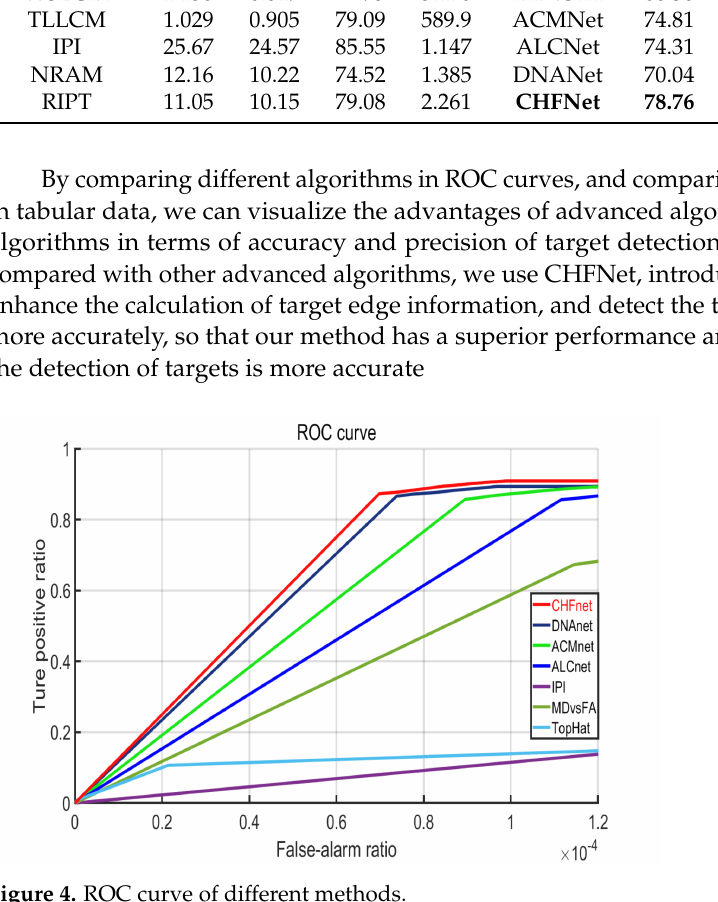
Figure 4. ROC curve of different